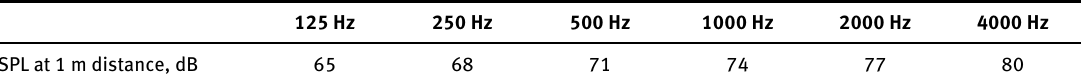
Table 2. Sound pressure level (SPL) at 1 m distance from sound source defined for speaker. 125 Hz 250 Hz 500 Hz 1000 Hz 2000 Hz 4000 Hz SPL at 1 m distance, dB 65 68 71 74 77 80